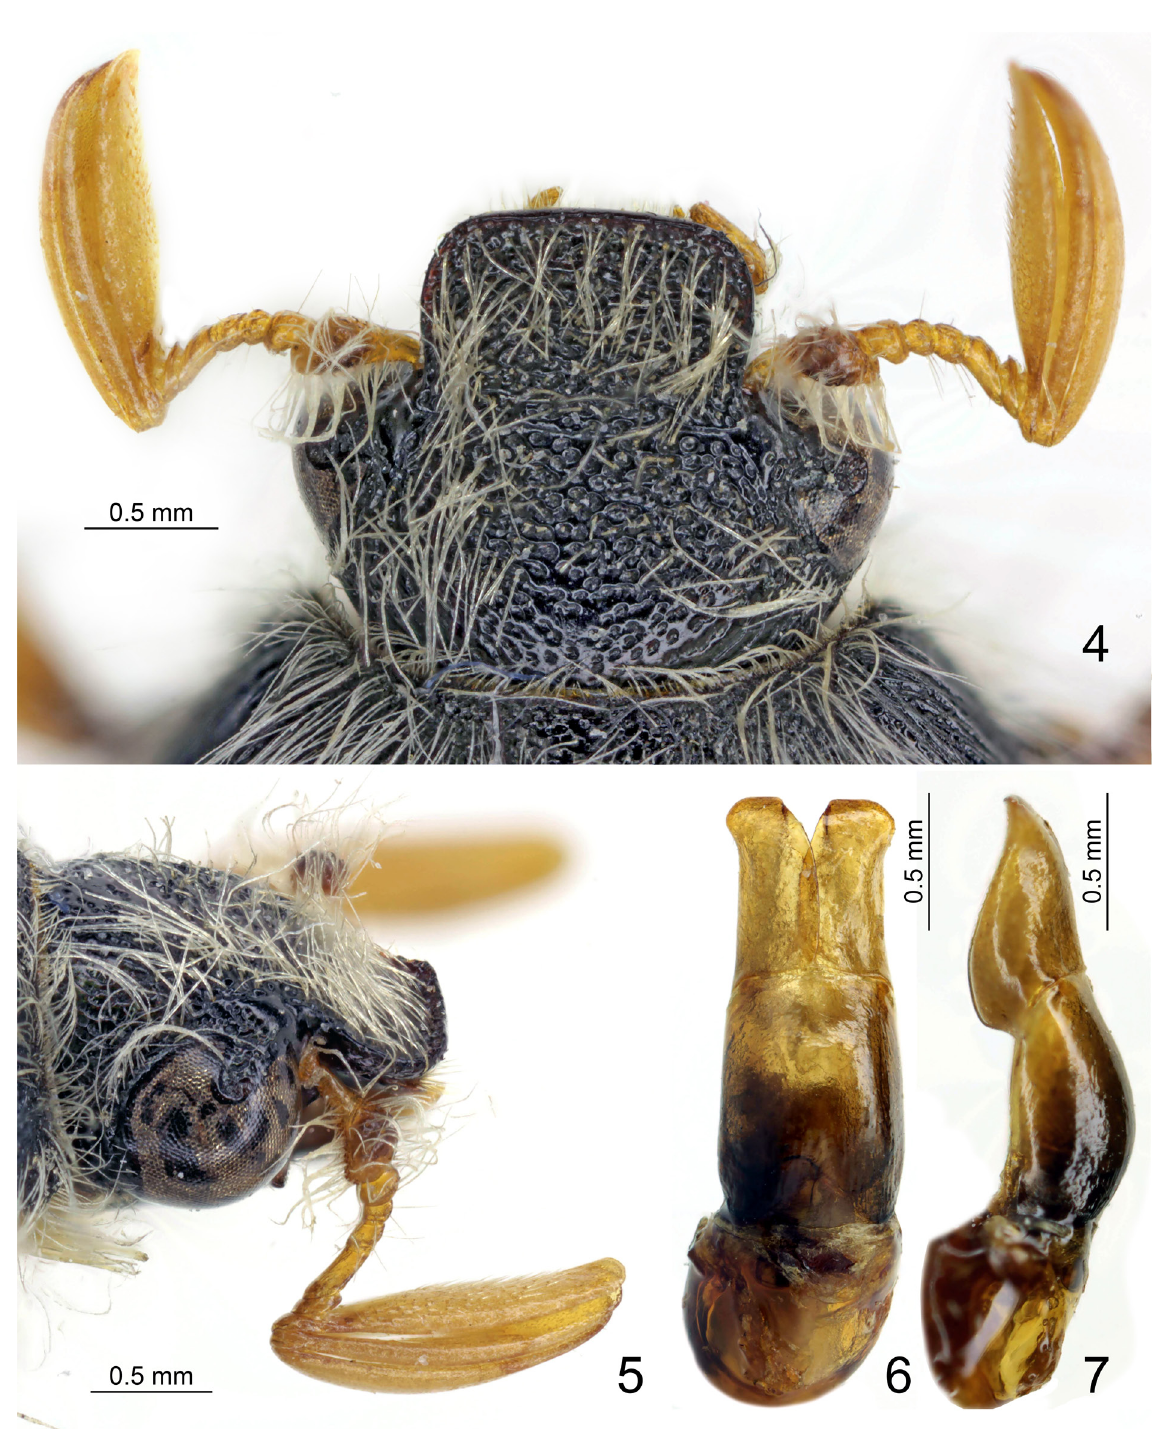
Figs 4–7. Araboplia lorisi gen. et sp. nov., ♂, holotype, anatomical details. 4 . Head in dorsal view. 5 . Head in oblique lateral view. 6 . Aedeagus in dorsal view. 7 . Aedeagus in lateral